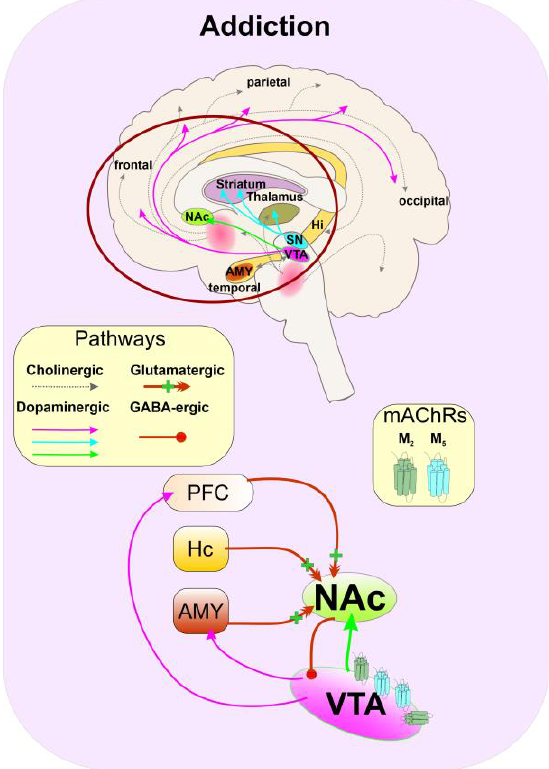
Figure 6. Schematic representation of the pathological dopaminergic circuitry in addiction. Repetitive rewarding stimulus induces excessive dopamine release from the ventral tegmental area (VTA) projections (pink lines) to the prefrontal cortex (PFC), amygdala (AMY), and most importantly to medial spiny neurons (MSNs) of nucleus accumbens (NAc) (light green), involved in the direct and indirect motor pathways (see Figure 5). Learned behaviour strengthens excitatory projections (red lines) from AMY, hippocampus (Hc), and PFC to NAc and supports addictive behaviour. MSNs of NAc containing D 1 receptors project back to the VTA and inhibit dopamine release. Inhibition or negative modulation of M 5 in the VTA might decrease dopamine release and prevent the further development of addiction according to [179,183].